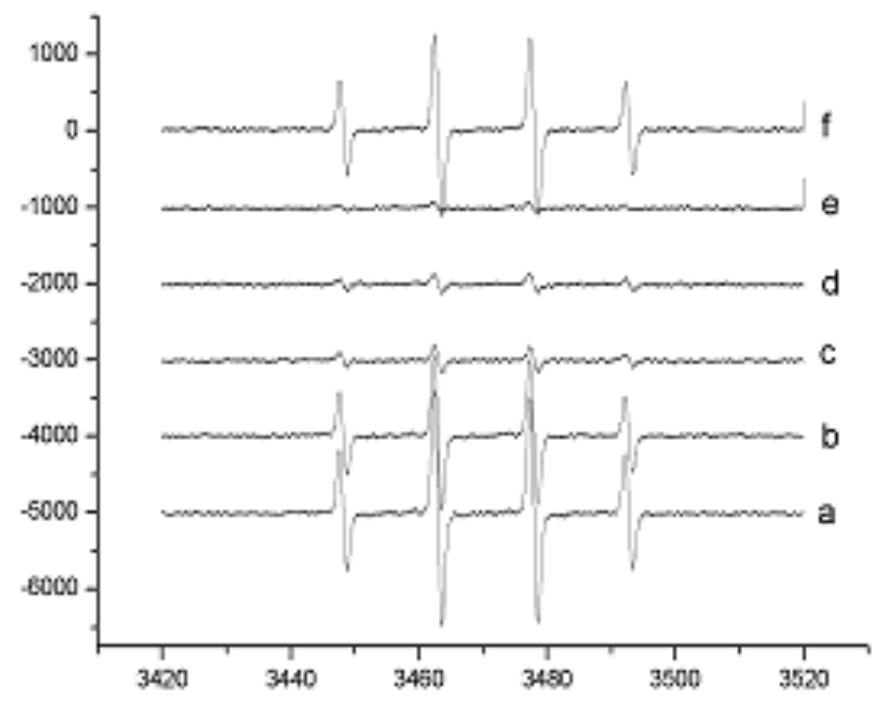
Figure 2 . The ESR spectrum of hydroxyl radicals and the dose dependent